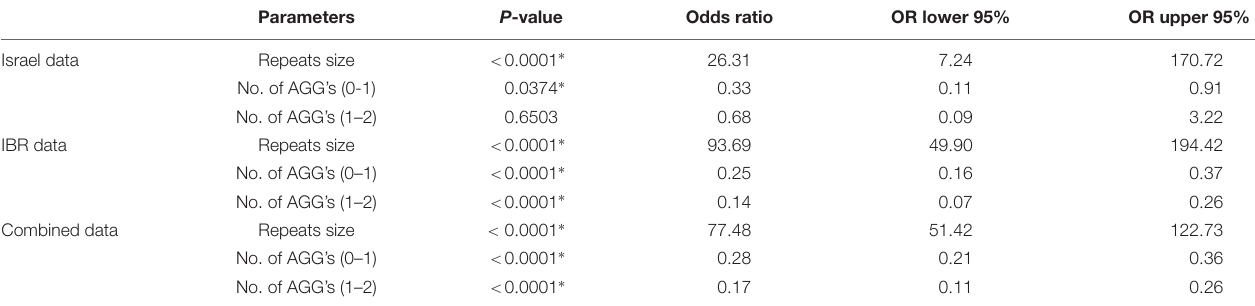
TABLE 5 | Summary of P -values, odds ratios and 95% CI of odd ratios from the regression models. Parameters P -value Odds ratio OR lower 95% OR upper